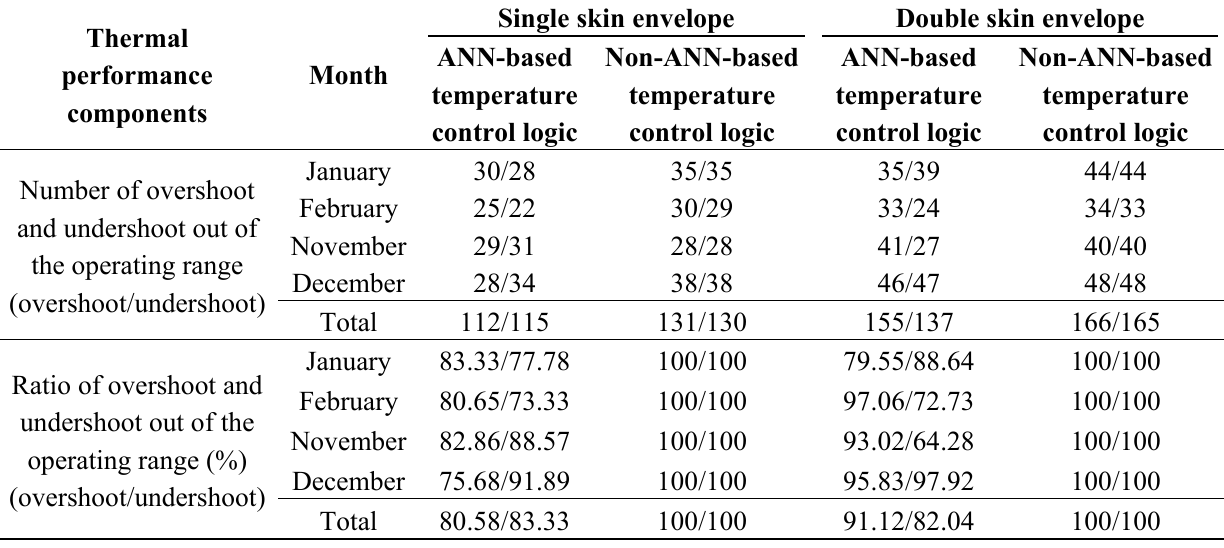
Table 5. Comparison of thermal performance between the ANN-based and non-ANN-based